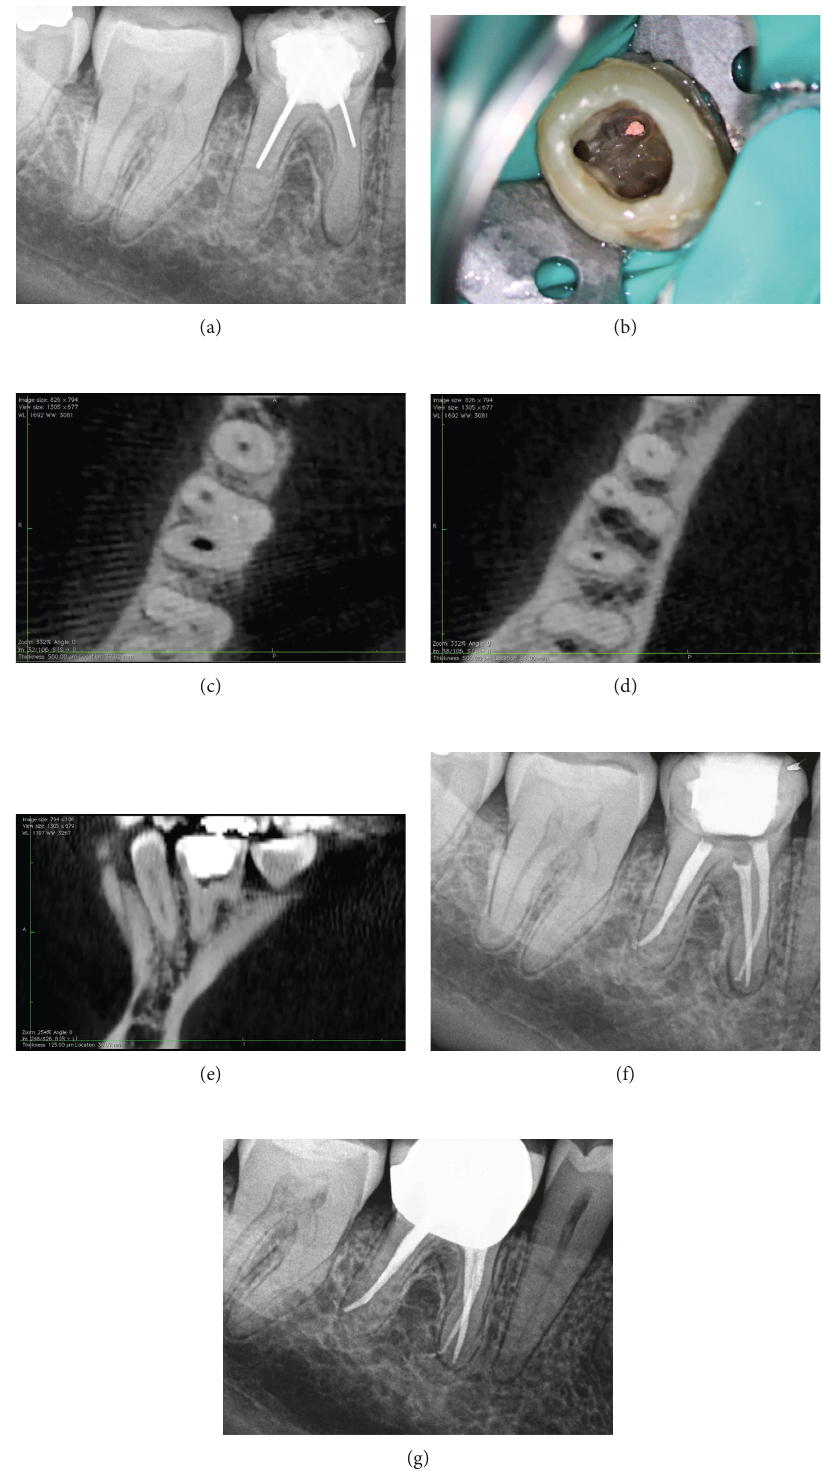
Figure 2: Treatment sequence of tooth 46. (a) Preoperative radiograph. (b) Clinical picture of gutta-percha point at the estimated position of the orifice of the mesiobuccal canal. (c) Axial view of intraoperative CBCT with gutta-percha point. (d) Axial view of intraoperative CBCT 2mm apically to the gutta-percha point. (e) Sagittal view of intraoperative CBCT with gutta-percha point. (f) Postoperative radiograph. (g) Radiograph at two-year